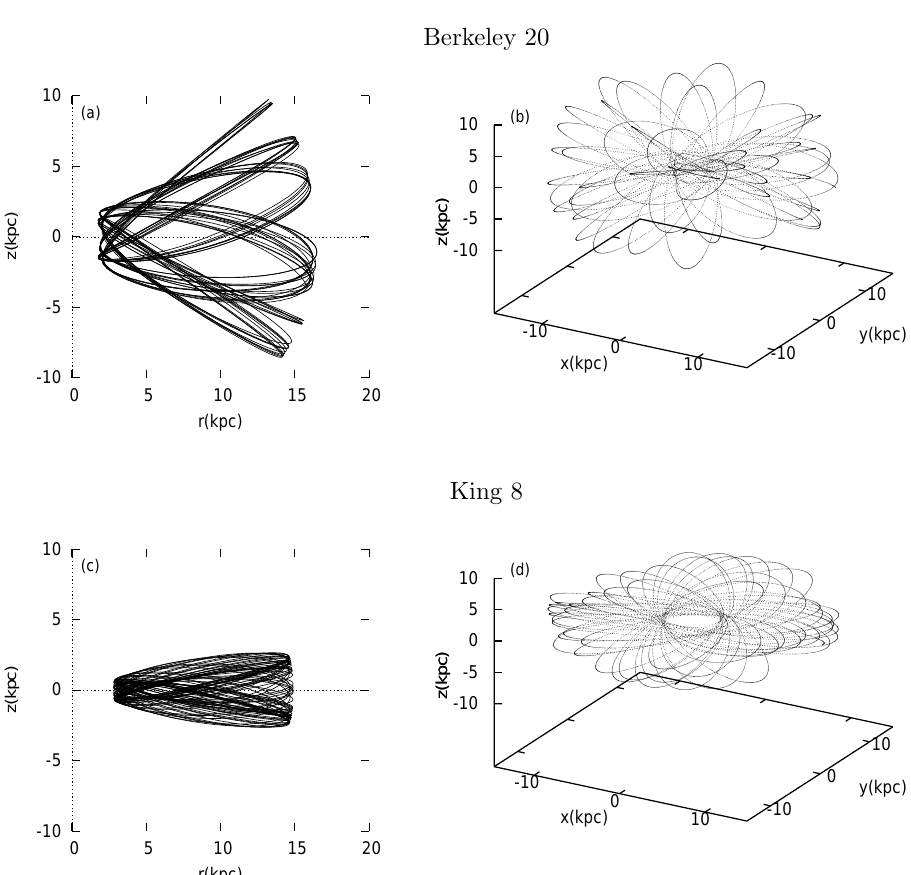
Fig. 1. Examples of orbits in the meridional plane (left) and in Cartesian coordinates (right). We computed the Lyapunov exponents (cid:21) for each phase-space coordinate. Ta- ble 2 lists the mean exponents (cid:21) with their errors, as well as the minimum and maximum (cid:21) values for the entire sample of open clusters. The exponents for four components are close to zero, however, those along the z and V r coordinates are significantly positive. Fig. 2 shows the Lyapunov exponent profiles for a cluster with the exponents tending to zero with